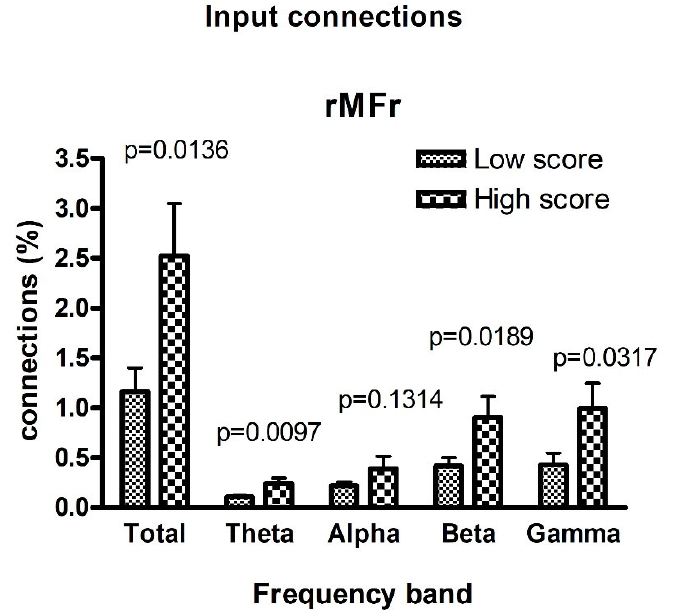
Figure 4. Comparison between the normalized connections entering a region ROI i in the two classes of subjects with lower and higher AQ scores, obtained using the spectral Granger connectivity. The comparison is performed using the overall connectivity computed in the entire frequency range ( sGC tot ) and the connectivity in the individual bands, with reference to the unique region k , ROI j → ROI i defined as an AQ-modulated sink ROI in Figure 2. Note that differences in the region rMFr are significant in the theta, beta, and gamma bands, but not in the alpha band.